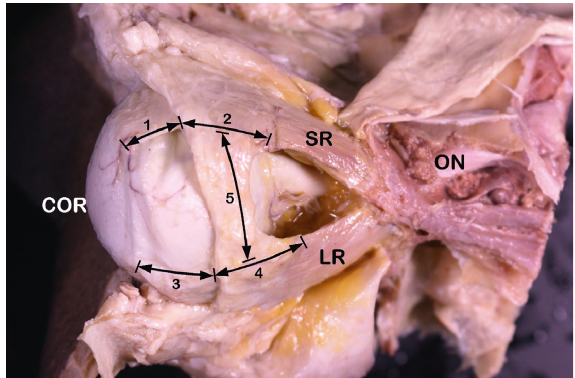
Figure 1: The orbit illustrating definitions of anatomical distances. (1): the distance from the anterior border of the lateral rectus muscle- superior rectus muscle (LR-SR) band to the SR insertion; (2): the length of the attachment site between the LR-SR band and the SR: (3), the distance from the anterior border of the LR-SR band to the LR insertion; (4): the length of the attachment site between the LR-SR band and the LR; (5): the width of the LR-SR band. ON � optic nerve; LR � lateral rectus muscle; SR � superior rectus